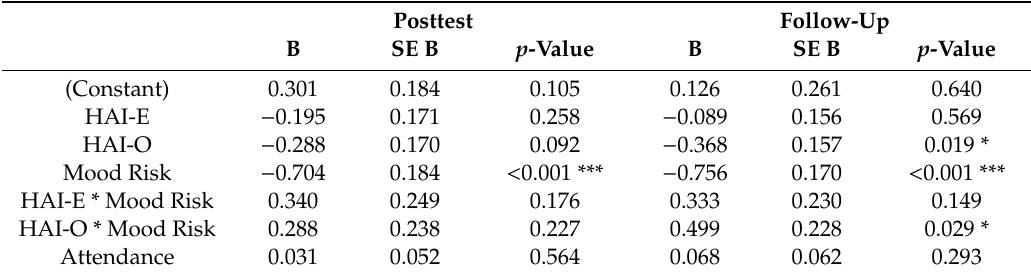
Table 3. Regression analyses modeling moderation e ff ects of mood risk and treatment condition on students’ learning and study strategies SKILL.